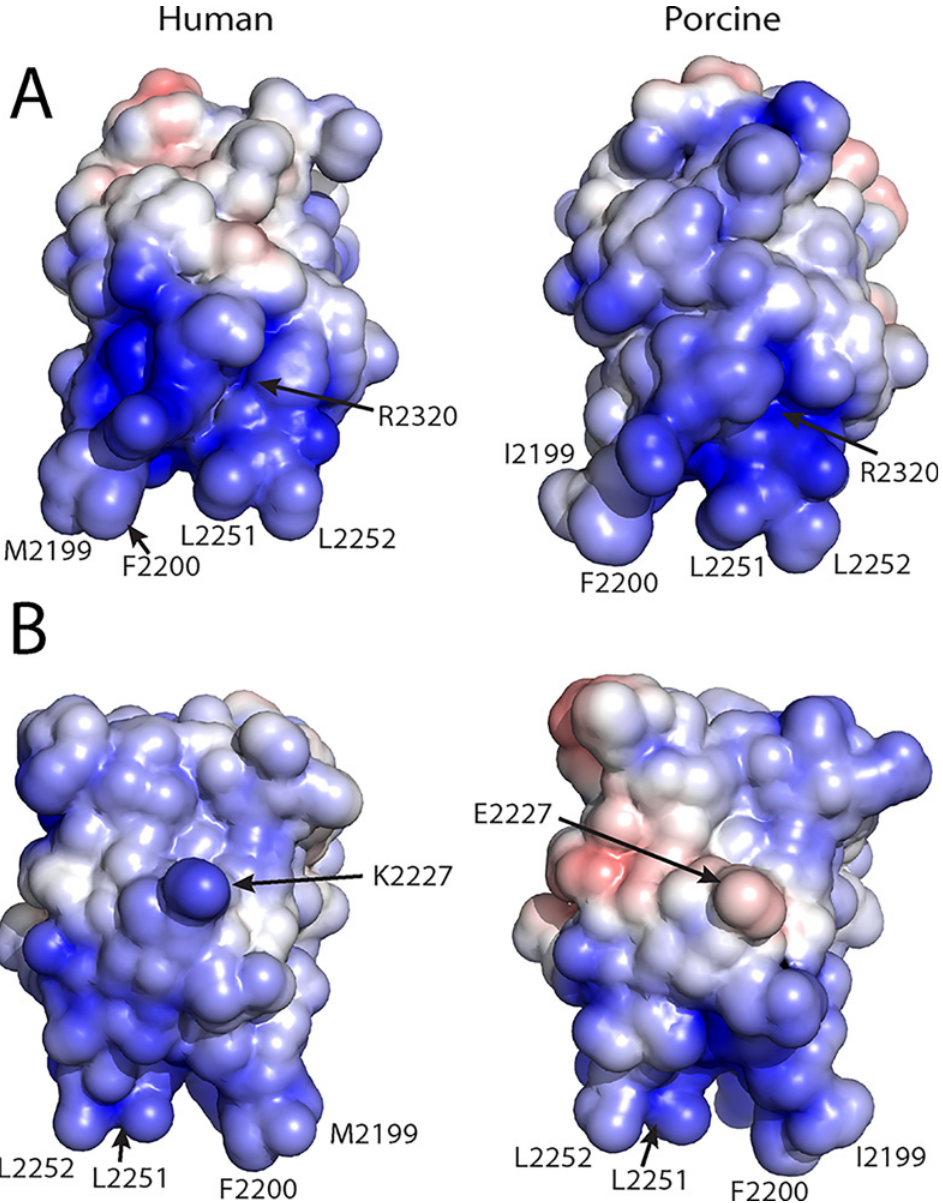
Fig 5. Electrostatic surface potentials for the human and porcine factor VIII C2 domain structures. (A) The 3E6 mAb epitope face. (B) The G99 mAb epitope face. The surface potential calculations were performed with APBS with surface potential values of ± 5 kT/e, and the surface were generated with PyMol (blue: positive charge, red: negative